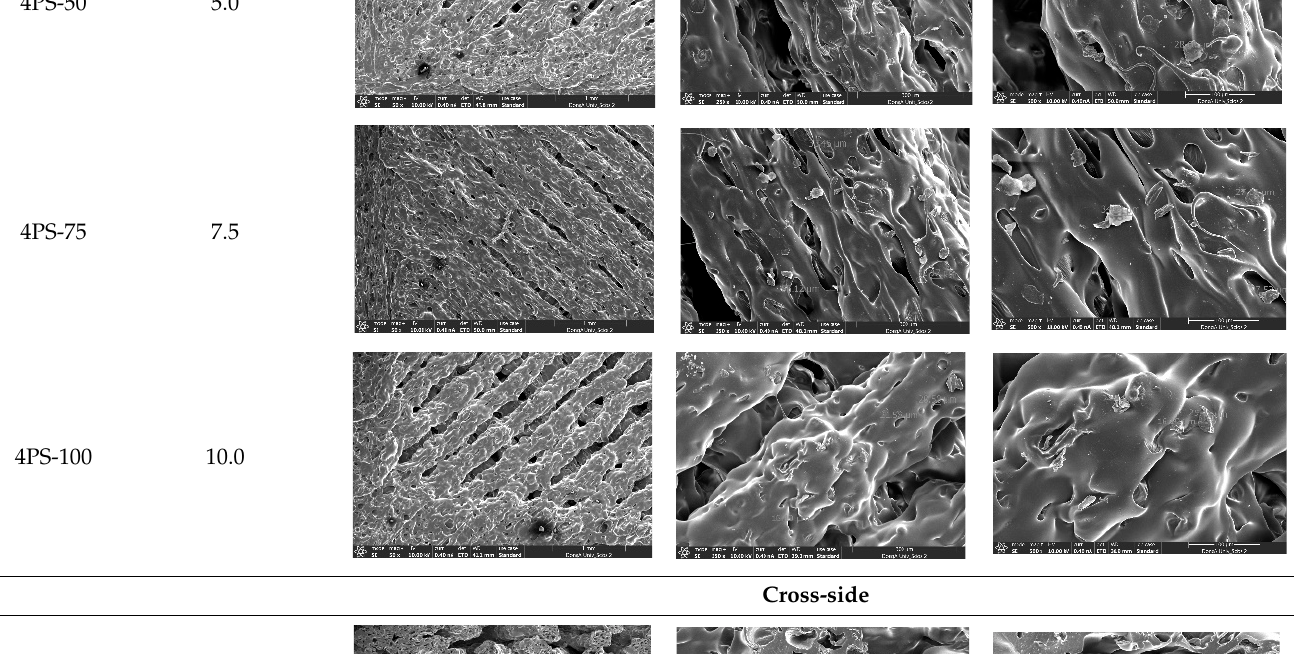
Table 3. Morphology image of surface and cross-side of the LW 3DP 4-PS outsole piece extruded in various thicknesses.